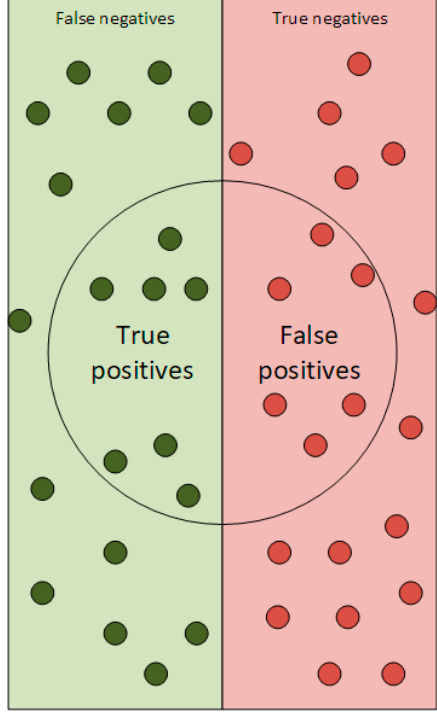
Figure 2. True Positives (TP), False Positives (FP), True Negatives (TN) and False Negatives (FN) illustration.